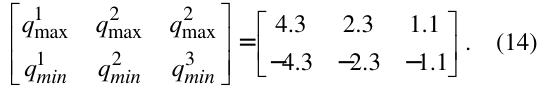
1 e through iterations max